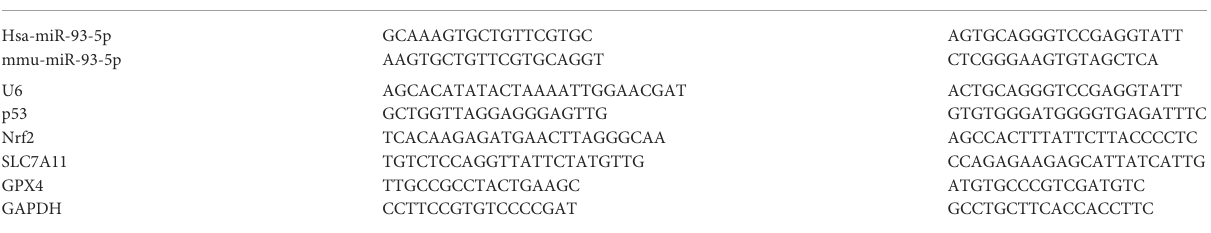
TABLE 1 Sequences of primers used for